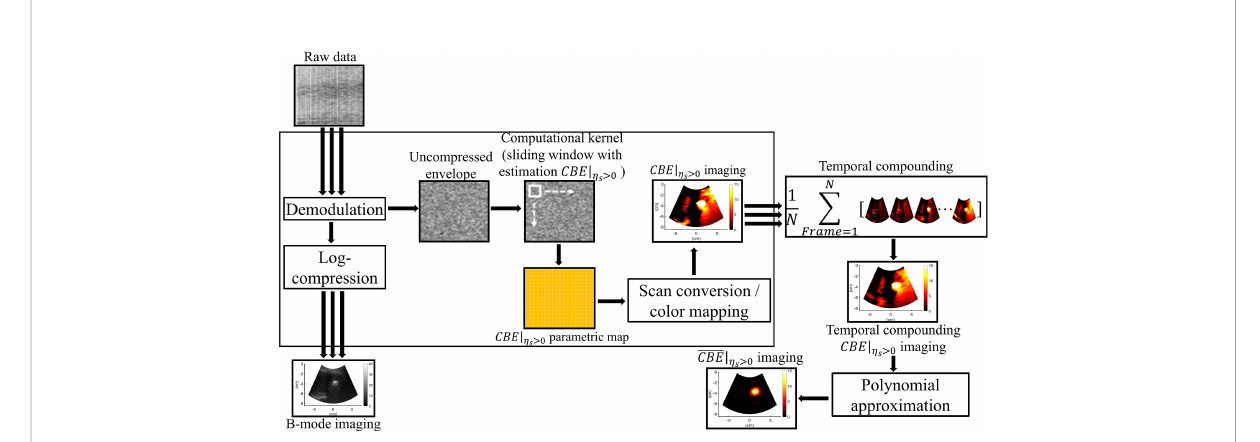
FIGURE 3 The algorithmic scheme for ultrasound single-phase CBE imaging. The uncompressed envelope signals were processed by the sliding window technique >0 images at different time points, which were further combined by temporal compounding. Polynomial approximation of the temporal to obtain CBE | h s compounding CBE | h >0 image (denoted by CBE j h ) was subsequently applied to visualize temperature distributions and heat conduction s > 0 s